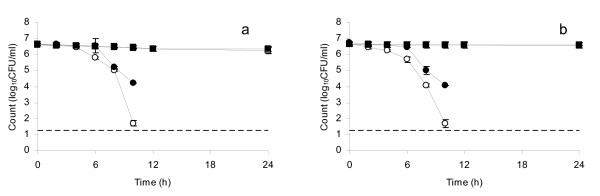
Plate counts of (a) V. cholerae 3906 and (b) V. cholerae O1 in distilled water at pH 7.5, 30°C stored in a copper vessel and enumerated under aerobic conditions (open circles) and ROS-n conditions (closed circles); (a) V. cholerae 3906 and (b) V. cholerae O1 in distilled water at pH 7.5, 30°C stored in a glass vessel and enumerated under aerobic conditions (open squares) and ROS-n conditions (closed squares). Error bars represent 95% confidence limits (n = 3). No counts were obtained at 24 h under any conditions. No counts were obtained after 10 h for bacteria kept in water in the copper vessel.